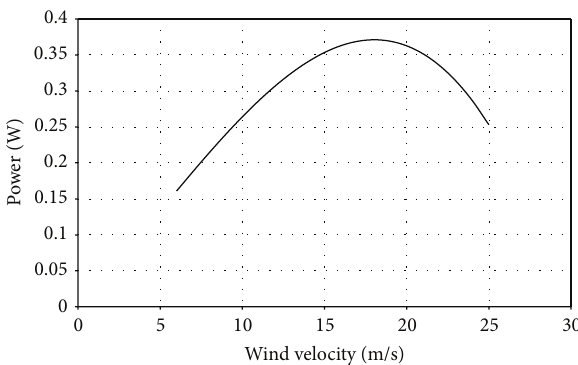
Figure 2: Small-scale wind turbine characteristic.